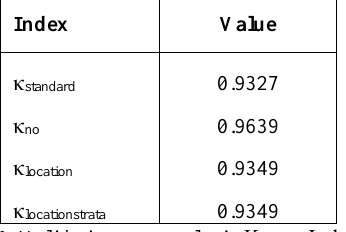
Table 1. Validation test results in Kappa Index (κ).